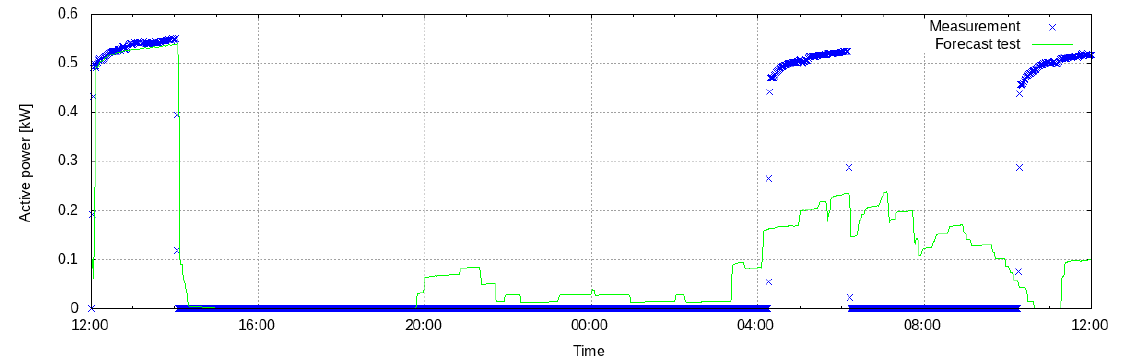
Figure 12. Ground truth and prediction of the power consumed by the heat pump within a 24-h forecast horizon (date: 11 March